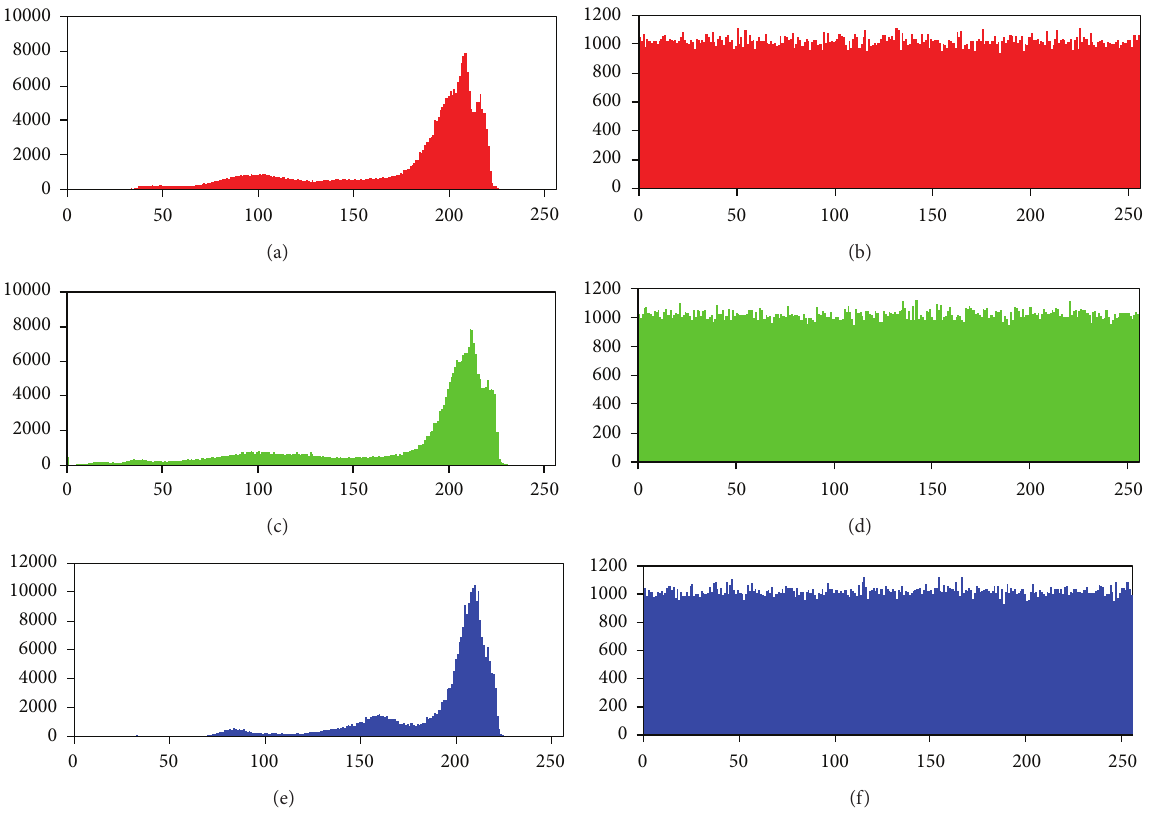
Figure 2: Histogram analysis of plain image and encrypted image: (a), (c), and (e) show the histograms of red, green, and blue channels of plain picture 4.2.05 Airplane (F-16); (b), (d), and (f) show the histograms of red, green, and blue channels of encrypted picture 4.2.05 Airplane